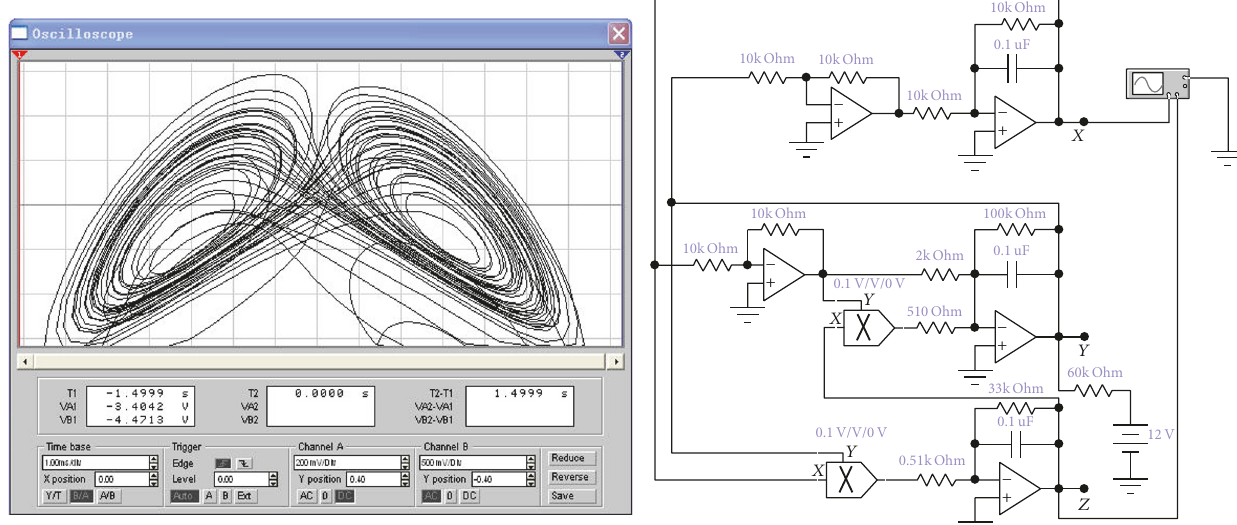
Figure 2: Lorenz-like chaotic circuit of system (2) using 5 amplifiers.